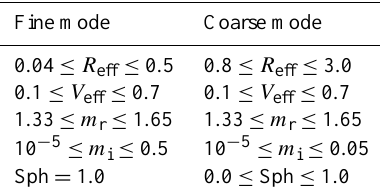
Table 2. The ranges of the aerosol parameters used to create the synthetic data set.